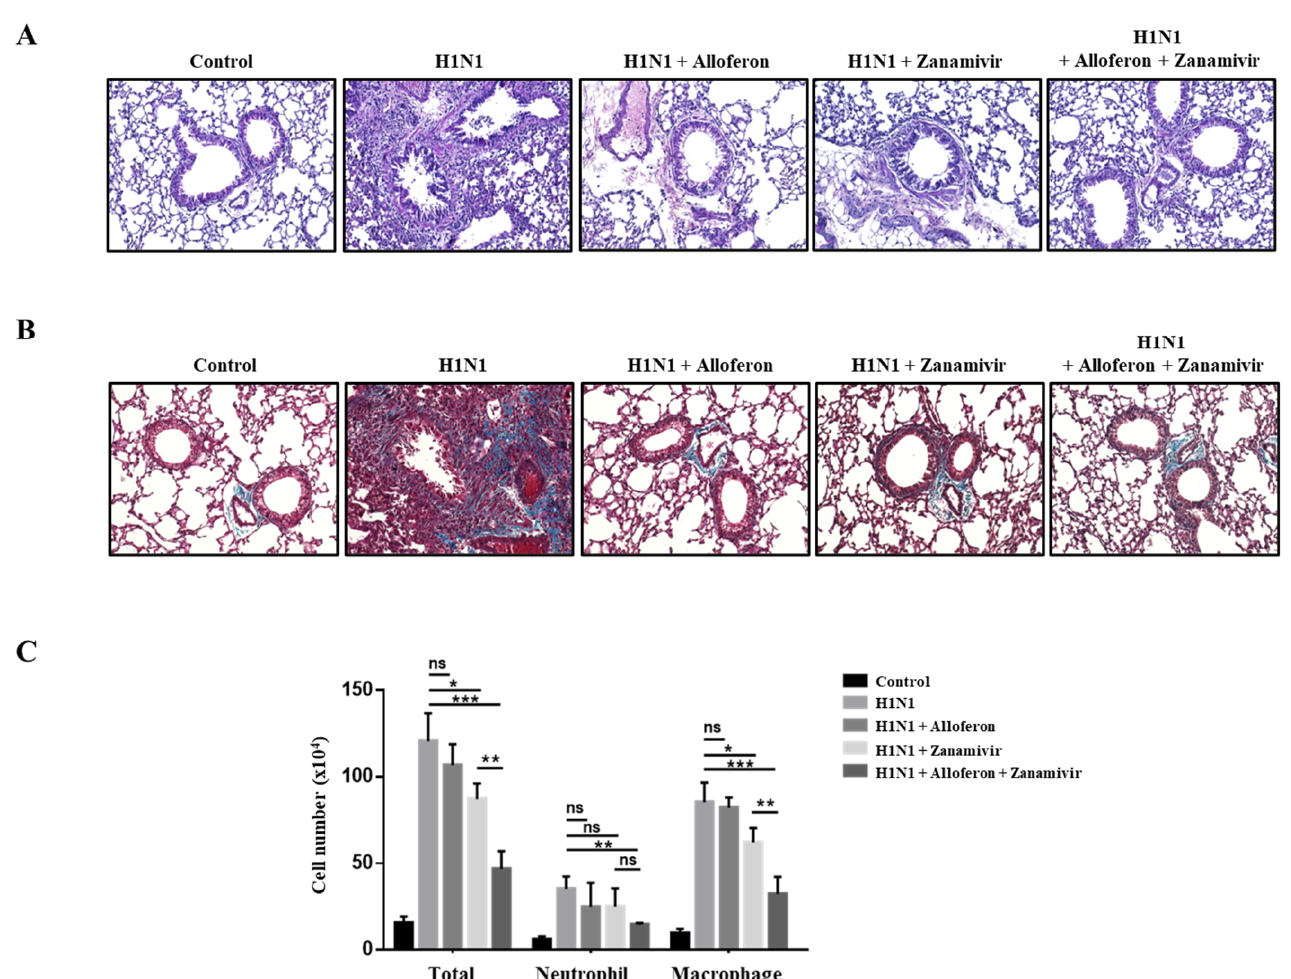
Figure 6. Pathological changes in the lung induced by infection with H1N1 were effectively prevented by combined treatment with alloferon (0.5 µ g/mL) and zanamivir (35 µ g/mL). Lung tissues were collected from mice and embedded in paraffin. Sectioning (4 µ m thick) and staining of tissues were performed as described in the Section 4. Cells were collected by flushing the lungs with ice-cold PBS containing EDTA (0.03%), and cell numbers were counted. ( A ) Hematoxylin & Eosin Staining. ( B ) Masson’s Trichrome staining. ( C ) Number of infiltrating inflammatory cells in the BALF. Results are representative of more than three independent experiments. * p < 0.1, ** p < 0.01, *** p < 0.001, NS; no significant. Scale bar, 100 μm.